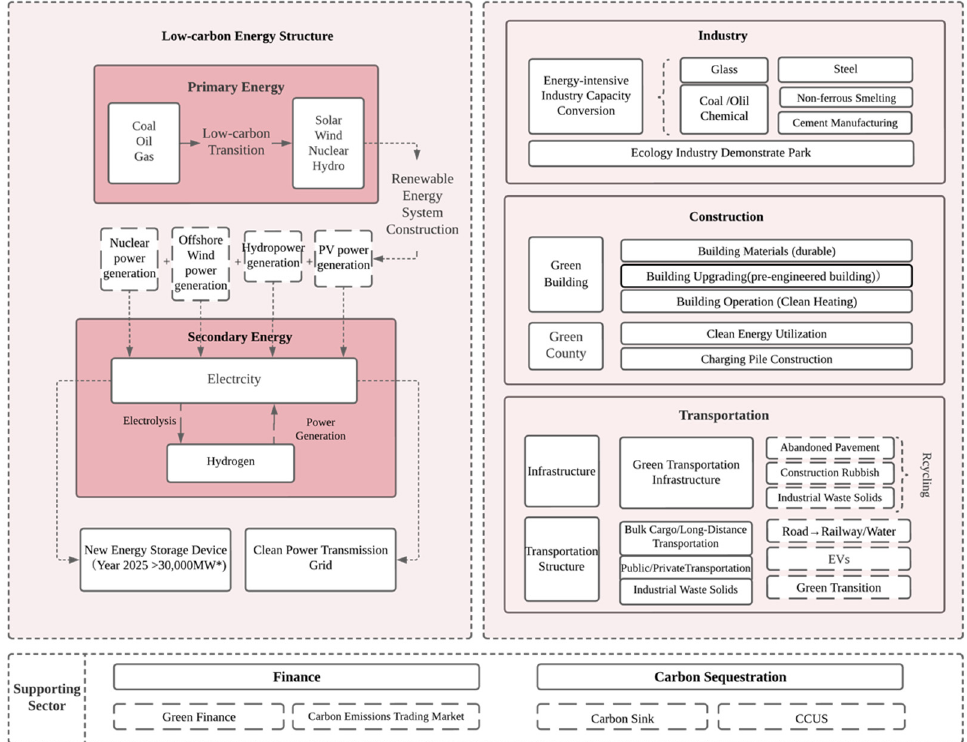
Figure 1. China’s carbon neutralized technologies highlights. * According to “State Council of the Action Plan for Carbon Dioxide Peaking Before 2030”, China aims to develop the new energy storage devices under the installation volume of 30,000 MW by 2025.